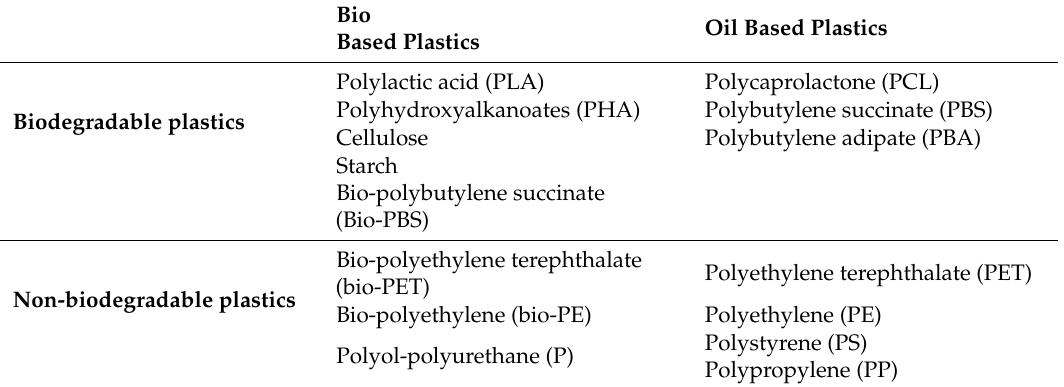
Figure 1. Four-way diagram of origin vs. end-of-life management for different polymers. Polymers originating from fossil fuels (polyethylene terephthalate (PET), polyethylene (PE), polystyrene (PS), polypropylene (PP)), or from renewable resource(s) (polybutylene succinate (PBS), polybutylene adipate (PBA), polycaprolactone (PCL)) can either be recycled or biodegraded. Biobased polyethylene terephthalate bio-PET and biobased polyethylene bio-PE are made from renewable resources and are recyclable. Polylactic acid, PLA; polyhydroxyalkanoates, PHA; biobased polybutylene succinate Bio-PBS are made from renewable resources and are biodegradable. Adapted from Emadian et al. 2017 and Narancic et al. 2018 [1,35]. Table 1. Categorisation of plastic types